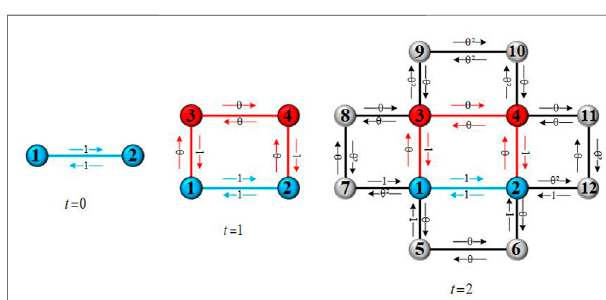
FIGURE 2 | DWEI network at t =0, 1, 2.